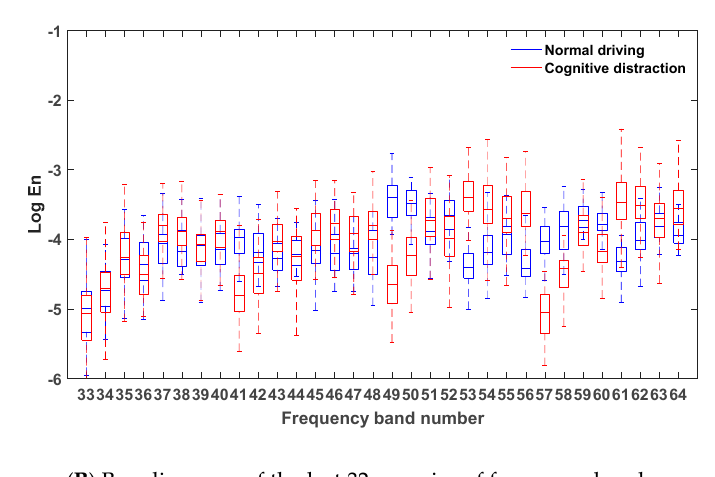
ff erent driving